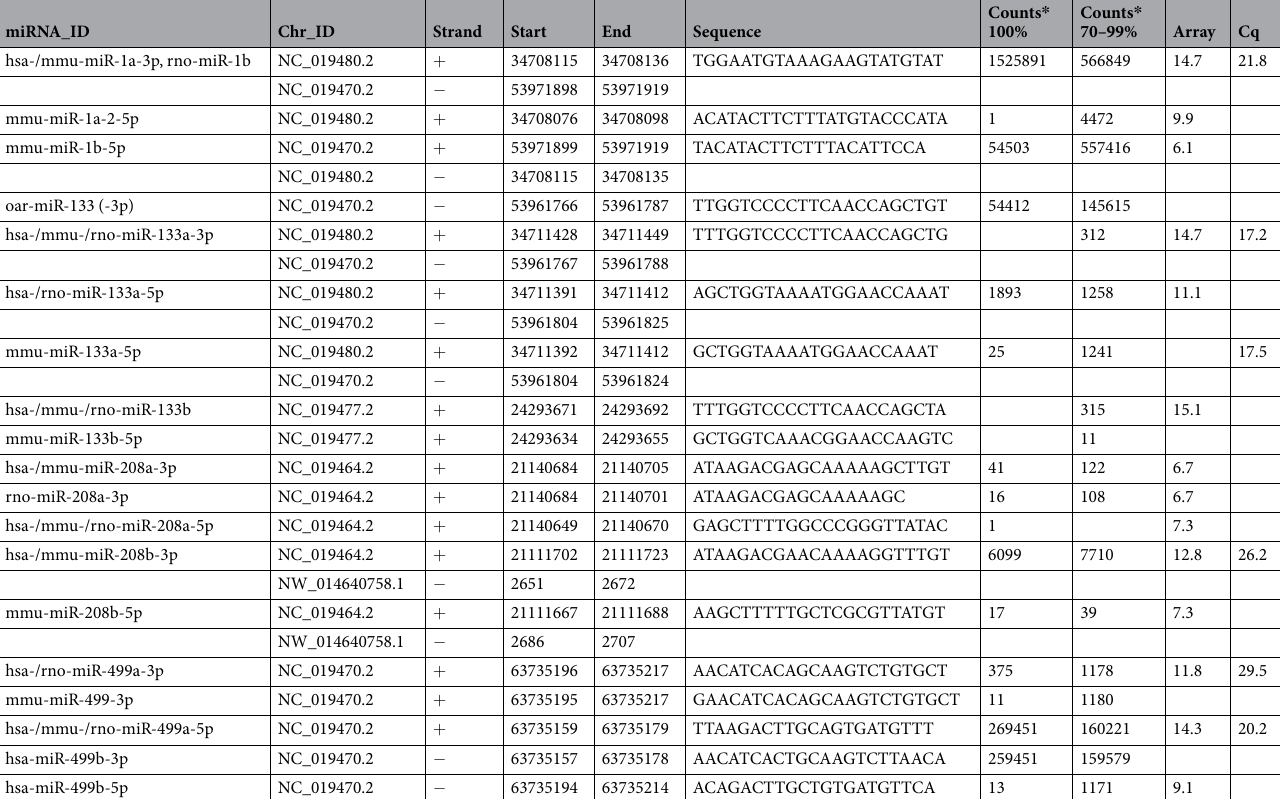
Table 2. Identification of cardiac-specific microRNAs in the sheep heart. * Mean counts of NGS sequencing. The detected sequences were 100% or 70–99% matched to existing miRNA